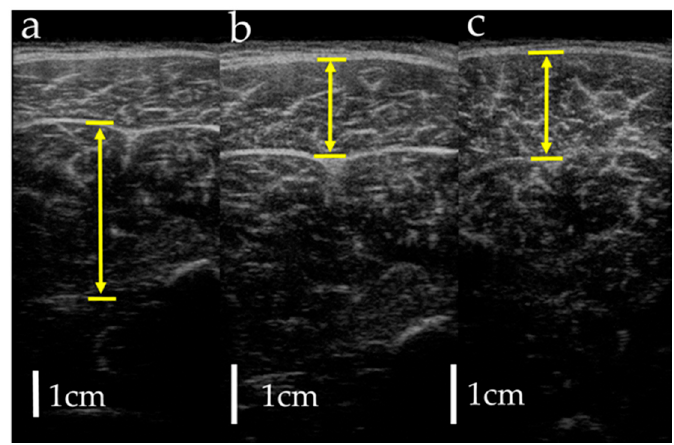
Figure 3. Measurement of muscle thickness by ultrasonography: ( a ) soleus; ( b ) gastrocnemius lateral head; ( c ) gastrocnemius medial head. Arrows indicate muscle thickness.